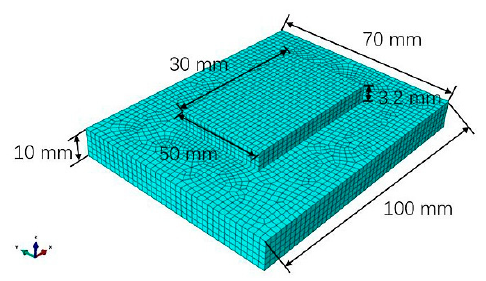
Figure 7. Finite element model and grid division.